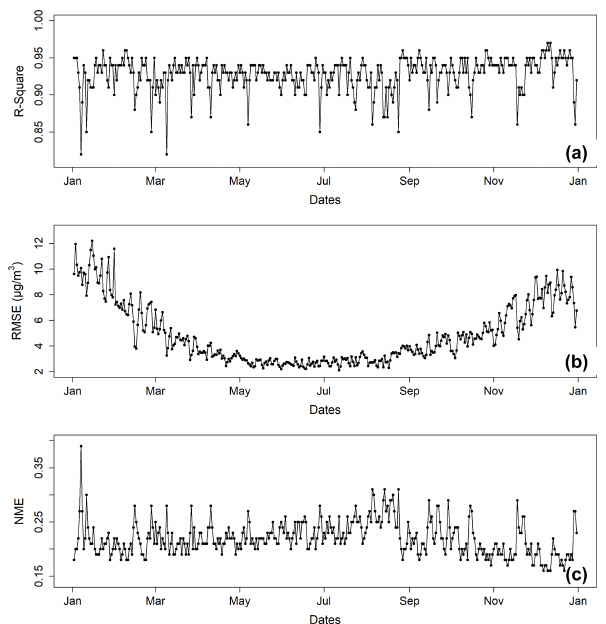
Figure 4. Daily prediction performance evaluated against the raw PM 2 . 5 CTM simulations in 2020: (a) R 2 , (b) RMSE, and (c) NME.